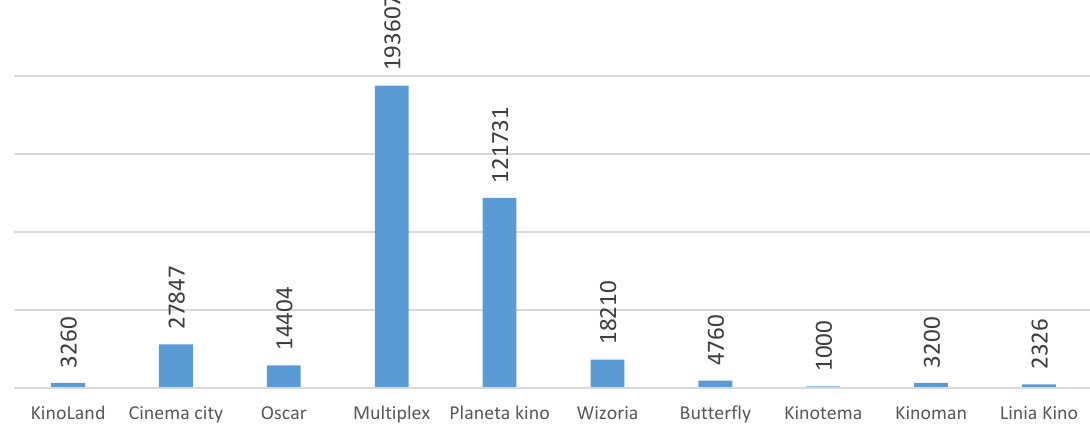
Figure 1. The number of cinema Facebook subscribers in July 2020